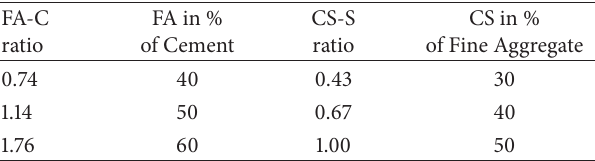
Table 3: FA-C and CS-S ratios in terms of % of materials replaced.